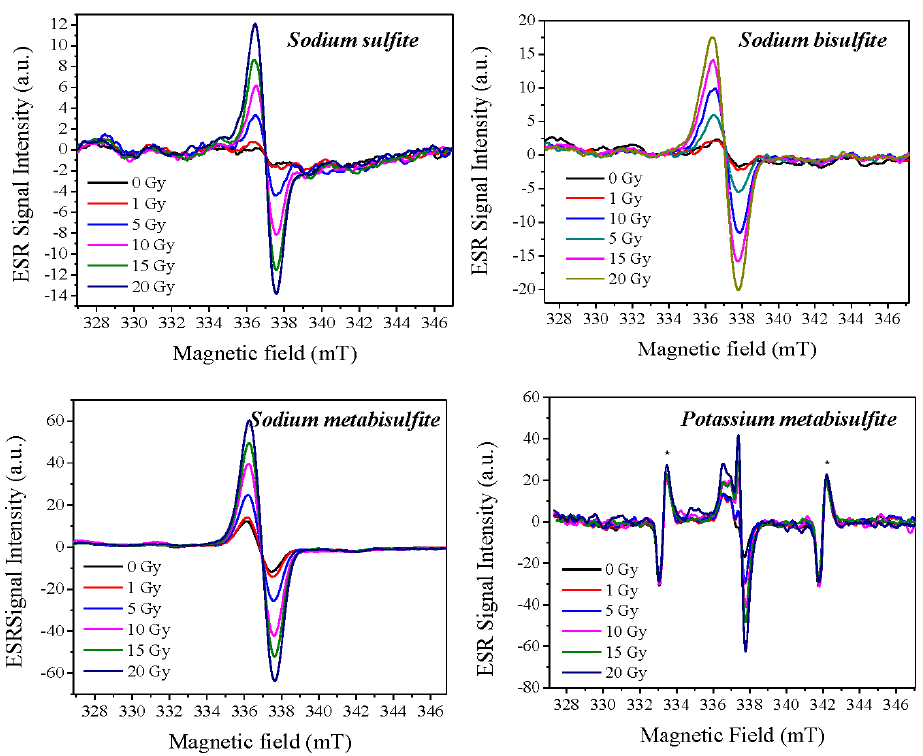
Molecules 2022 , 27 , x FOR PEER REVIEW Figure 5. Spectra of sulfites corresponding to each absorbed dose to build the Dose–Response Curve. The 3rd and 4th Mn 2+ lines of marker are indicated in the Potassium metabisulfite figure (*).